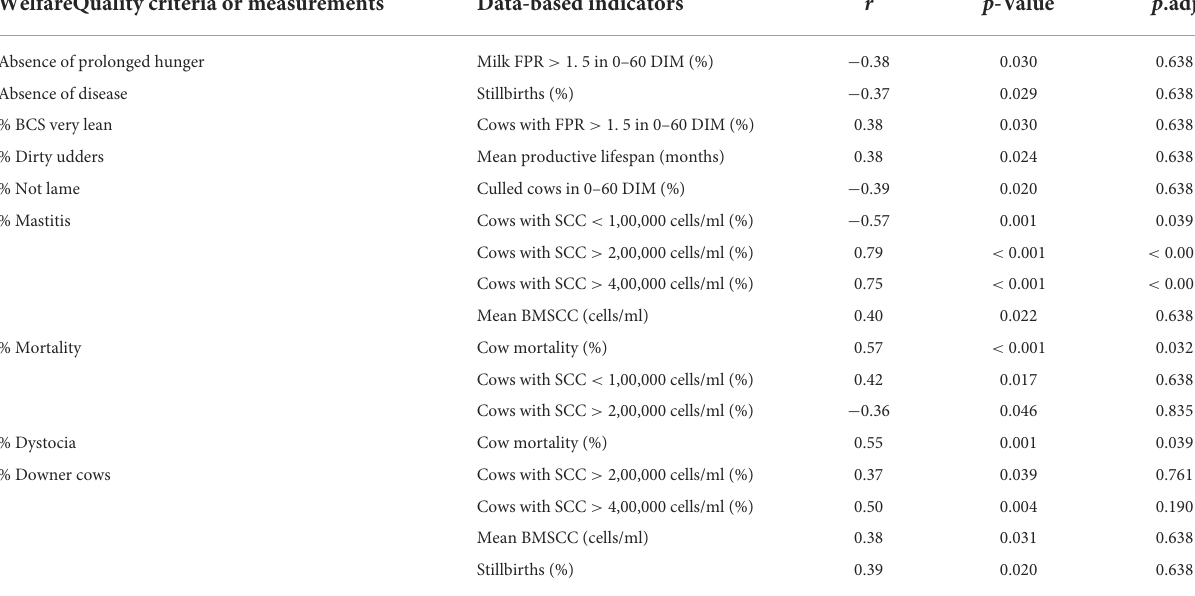
TABLE 4 Associations between measurements and criteria of the WelfareQuality ® -Protocol and data-based indicators. Associations with an adjusted p < 0.05 are highligted in gray. WelfareQuality criteria or